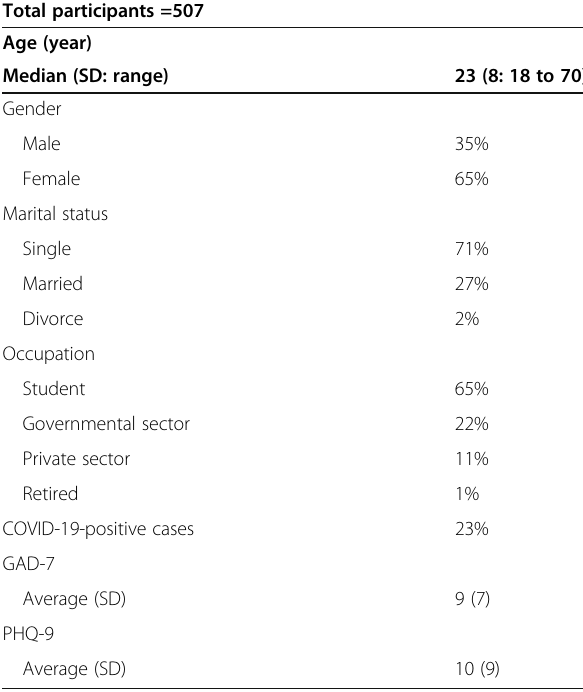
Table 2 Descriptive data included all participants in our analytic sample